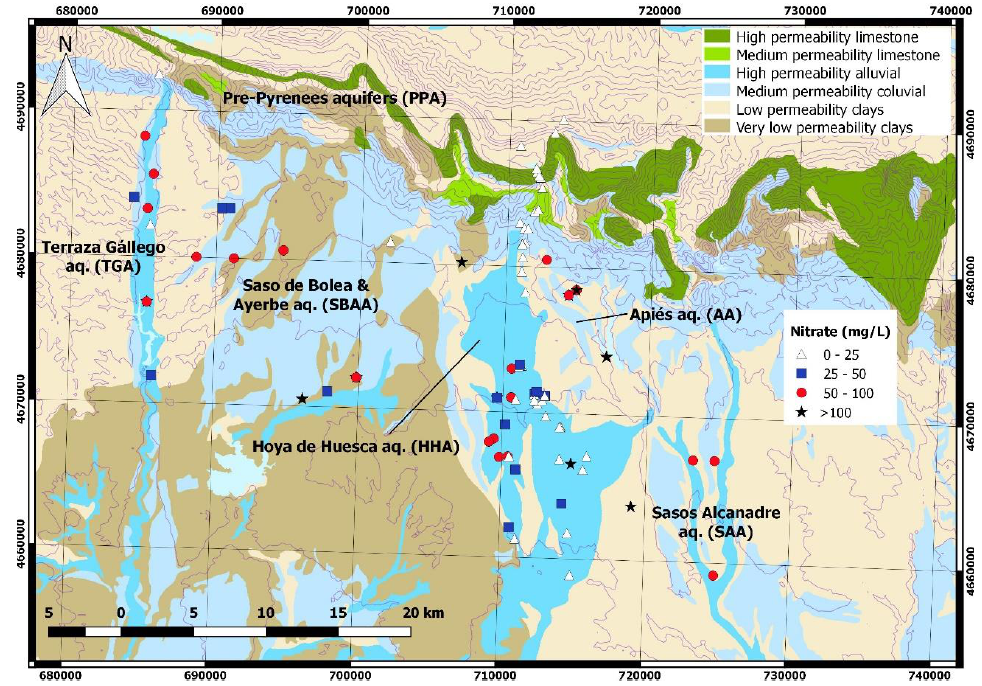
Figure 4. Spatial distribution of nitrate contents in the studied aquifers on a Spanish Geological Survey (IGME) map of Spanish aquifers [32].